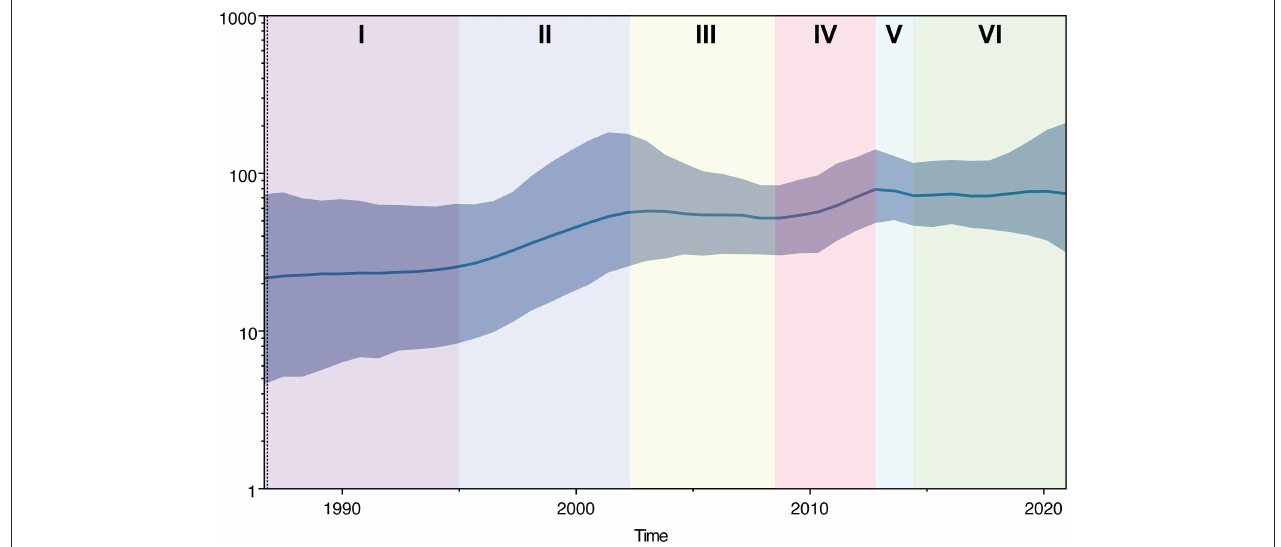
FIGURE 5 | Bayesian SkyGrid plot displaying the changes in effective population size of PPMV-1 strains circulating in China over time. The dark blue line denotes the mean value of genetic diversity and the light blue shading indicates the 95% confidence interval. Different colors represent different phases.